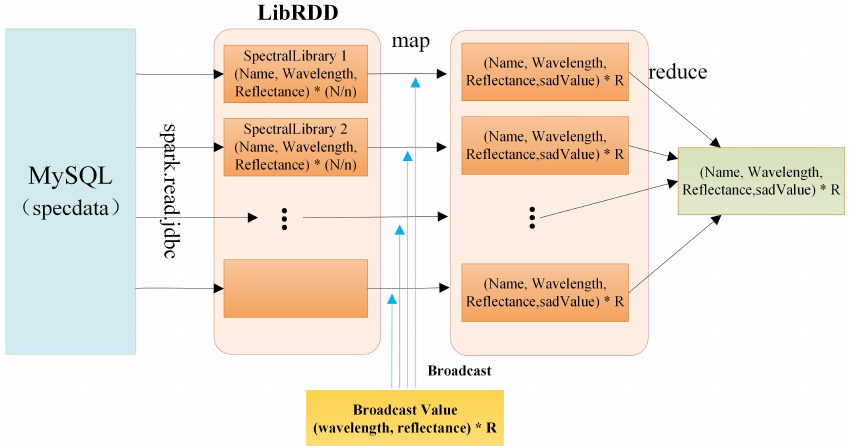
Figure 7. Parallel and distributed implementation of spectral angle distance